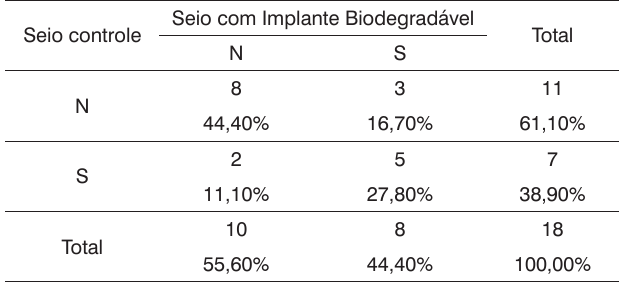
Tabela 3. Padrão Inflamatório nos seios controles e nos seios com implantes biodegradáveis.